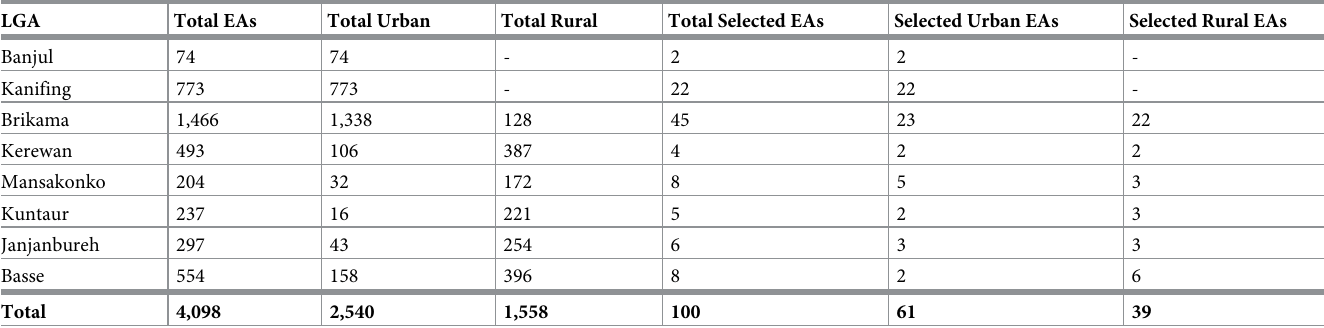
Table 1. Allocation of Enumeration Areas (EAs) to different strata.